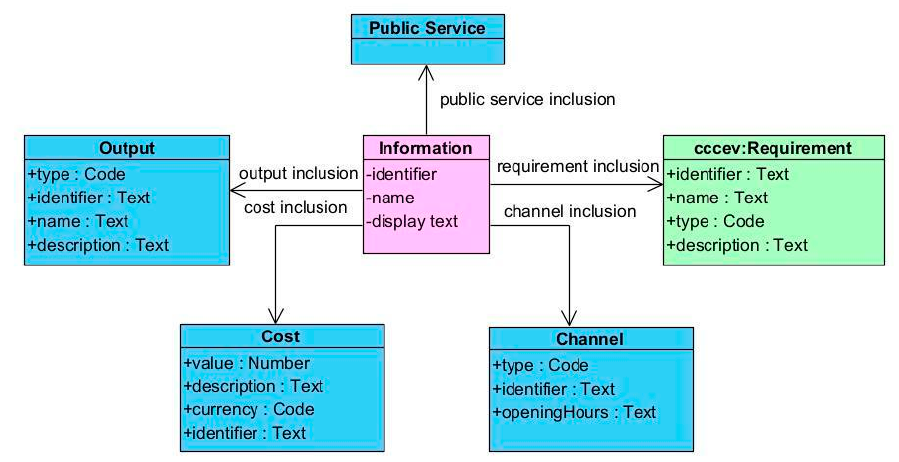
Figure 6. Chatbot specific enhancement of CPSV-AP.